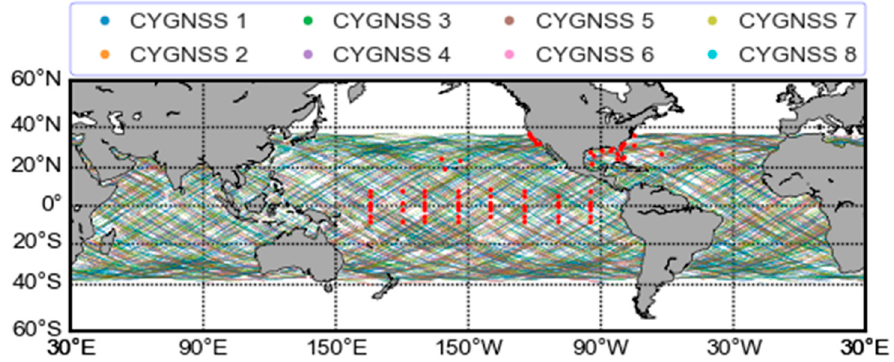
Figure 4. The distribution of daily specular point tracks of 8 CYGNSS satellites and buoys.